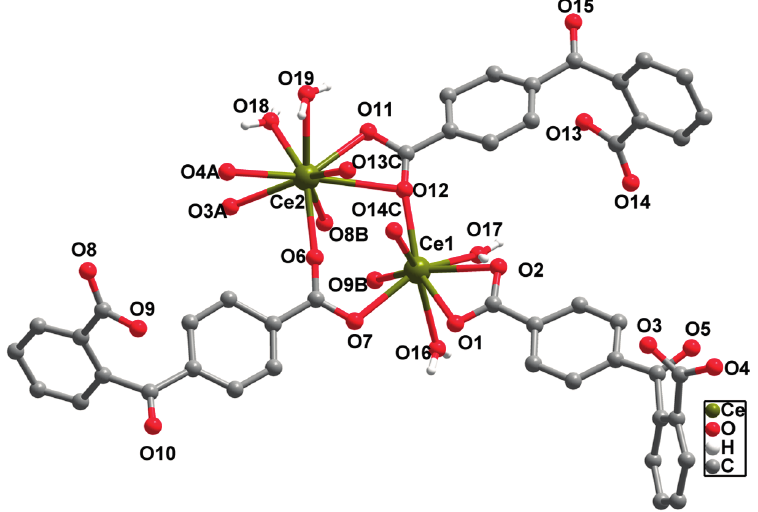
Figure 4. The coordination environment of Ce (III) center of 2 . Symmetry codes, A: x + 1/2, − y + 1/2, z + 1/2; B: x + 1/2, y + 1/2, z ; C: x − 1/2, y − 1/2, z . All H atoms are omitted for